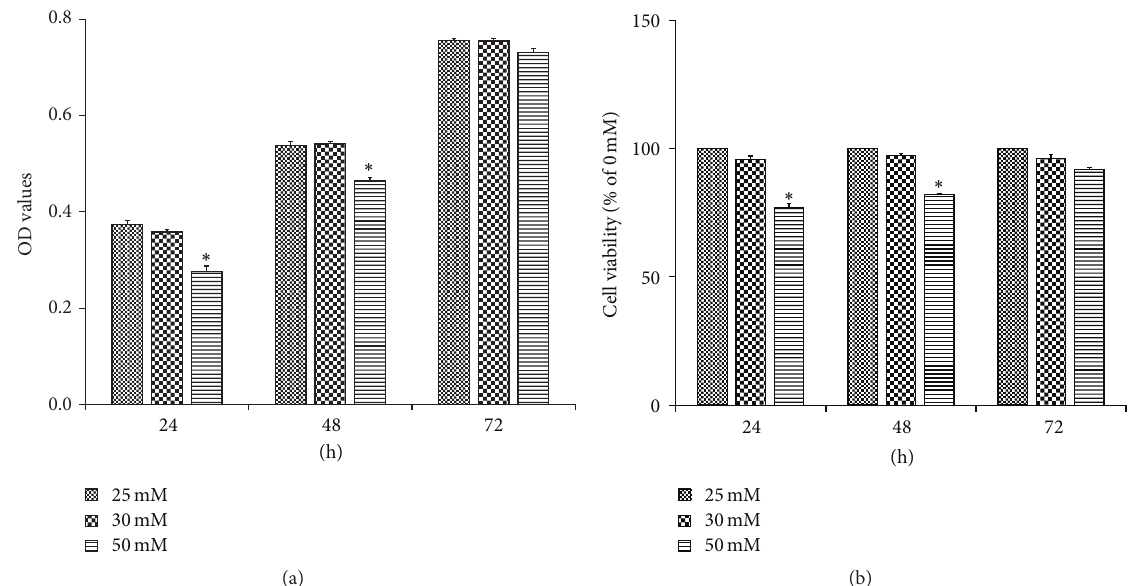
Figure 2: MTT cell viability assay results obtained at 24h, 48 h, and 72 h displayed in terms of optical density (a) and the percentage of viable cells (% of 0 mM) (b). There was no significant difference between control group and low glucose group (30 mM); however the MTT uptake ability in high glucose group (50mM) was significantly decreased revealing a significantly lower cell viability ( 𝑃 < 0.05 ).